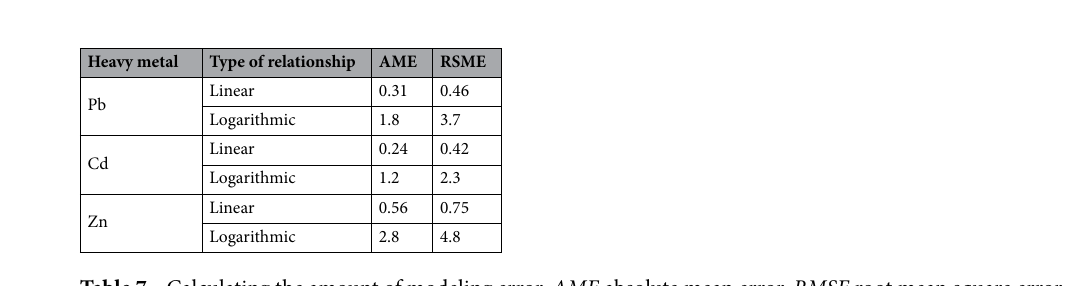
Table 7. Calculating the amount of modeling error. AME absolute mean error. RMSE root mean square